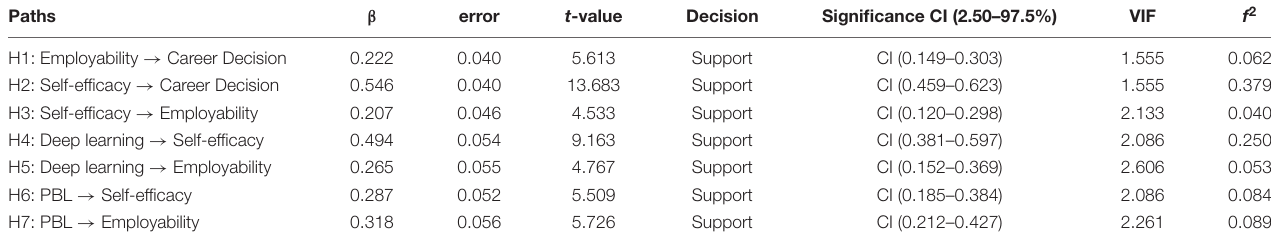
FIGURE 2 | Results of structural model. ∗∗∗ if p < 0.001. TABLE 2 | Results of the hypotheses testing.